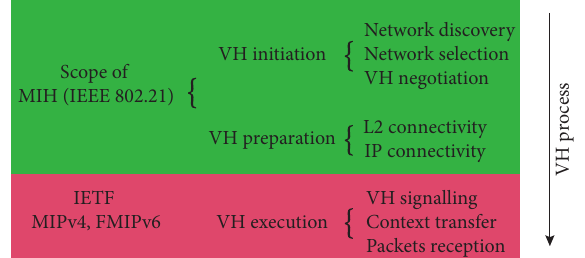
Figure 1: Steps of the general VH